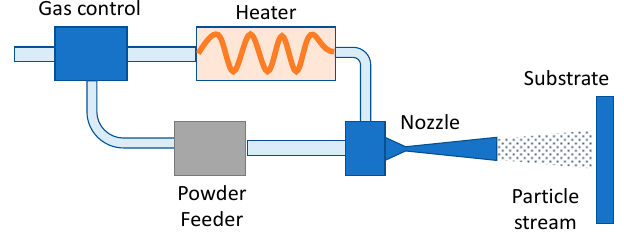
Figure 1. Diagram of the cold spray process.